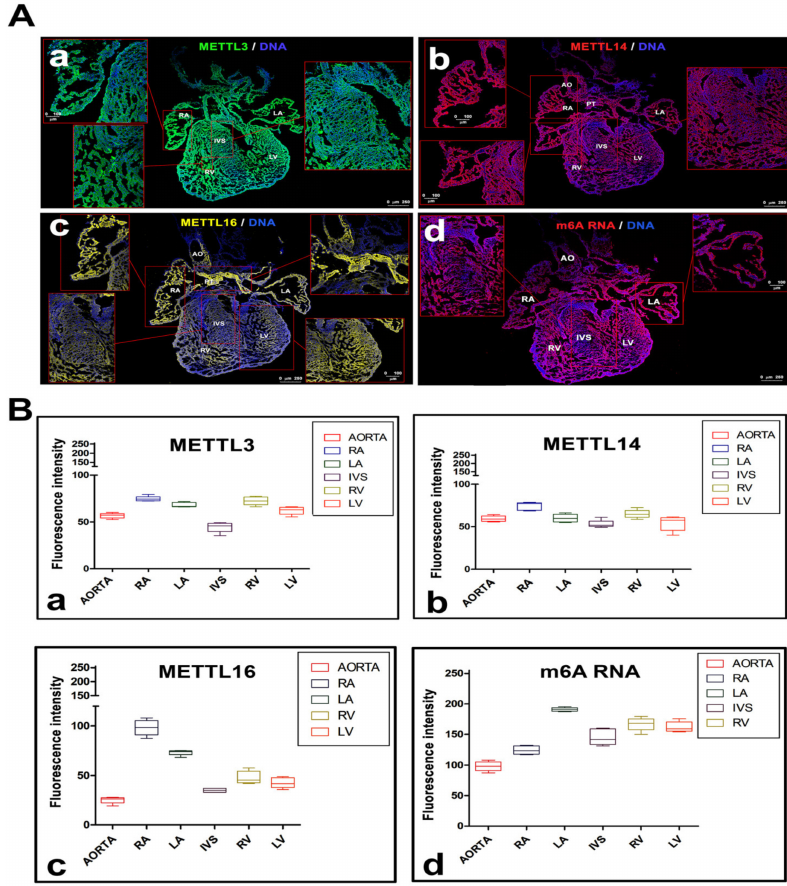
Figure 1. The distribution pattern of methyltransferase-like METTL3, METTL14, METTL16 proteins, and N 6 -adenosine methylation (m6A) in RNAs in mouse embryonic hearts, isolated at stage e15. ( A ) Immunofluorescence analysis of ( a ) METTL3, ( b ) METTL14, ( c ) METTL16 proteins and ( d ) m6A RNAs was done in the right atrium (RA), left atrium (LA), aorta (AO), right ventriculus (RV) and left ventriculus (LV) orintraventricularseptum(IVS).ScalebarsinthemainpanelsAa-dshow100 µ m. ( B )Immunofluorescence (IF) in panels A ( a – d ) was quantified by LAS AF software (Leica microscopy, Mannheim, Germany). Data are shown for ( a ) METTL3, ( b ) METTL14, ( c ) METTL16 proteins, and ( d ) m6A RNAs. IF was studied in anatomical regions, described in panels A ( a – d ). Experiments were repeated twice, and for each experimental event, 20 cryo-sections of mouse embryonic hearts were acquired by tile scanning microscopy. Panels A ( a – d ) show representative examples of protein distribution that were quantified in panels Ba-d. Quantification was done in the following way: in each individual measurement, FI of background in the given channel was subtracted from FI acquired for the given